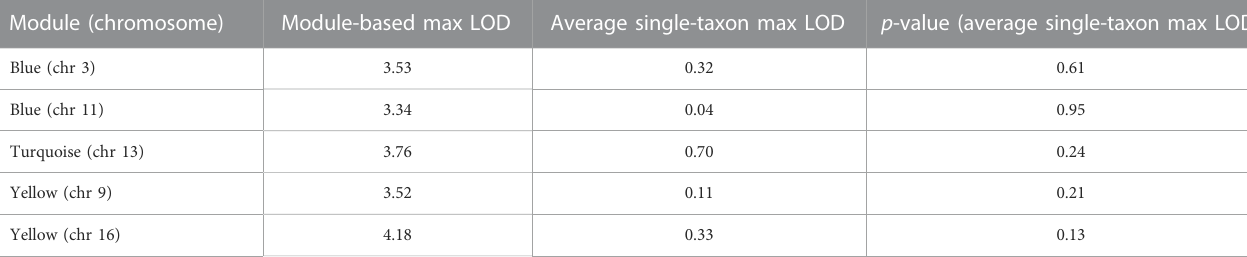
TABLE 4 Comparison of linkage signals from module-based and single-taxon level linkage analysis. Module